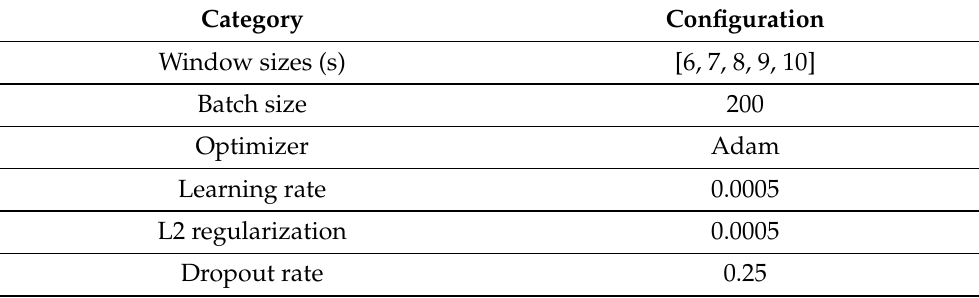
Table A5. WISDM DTE CNN model